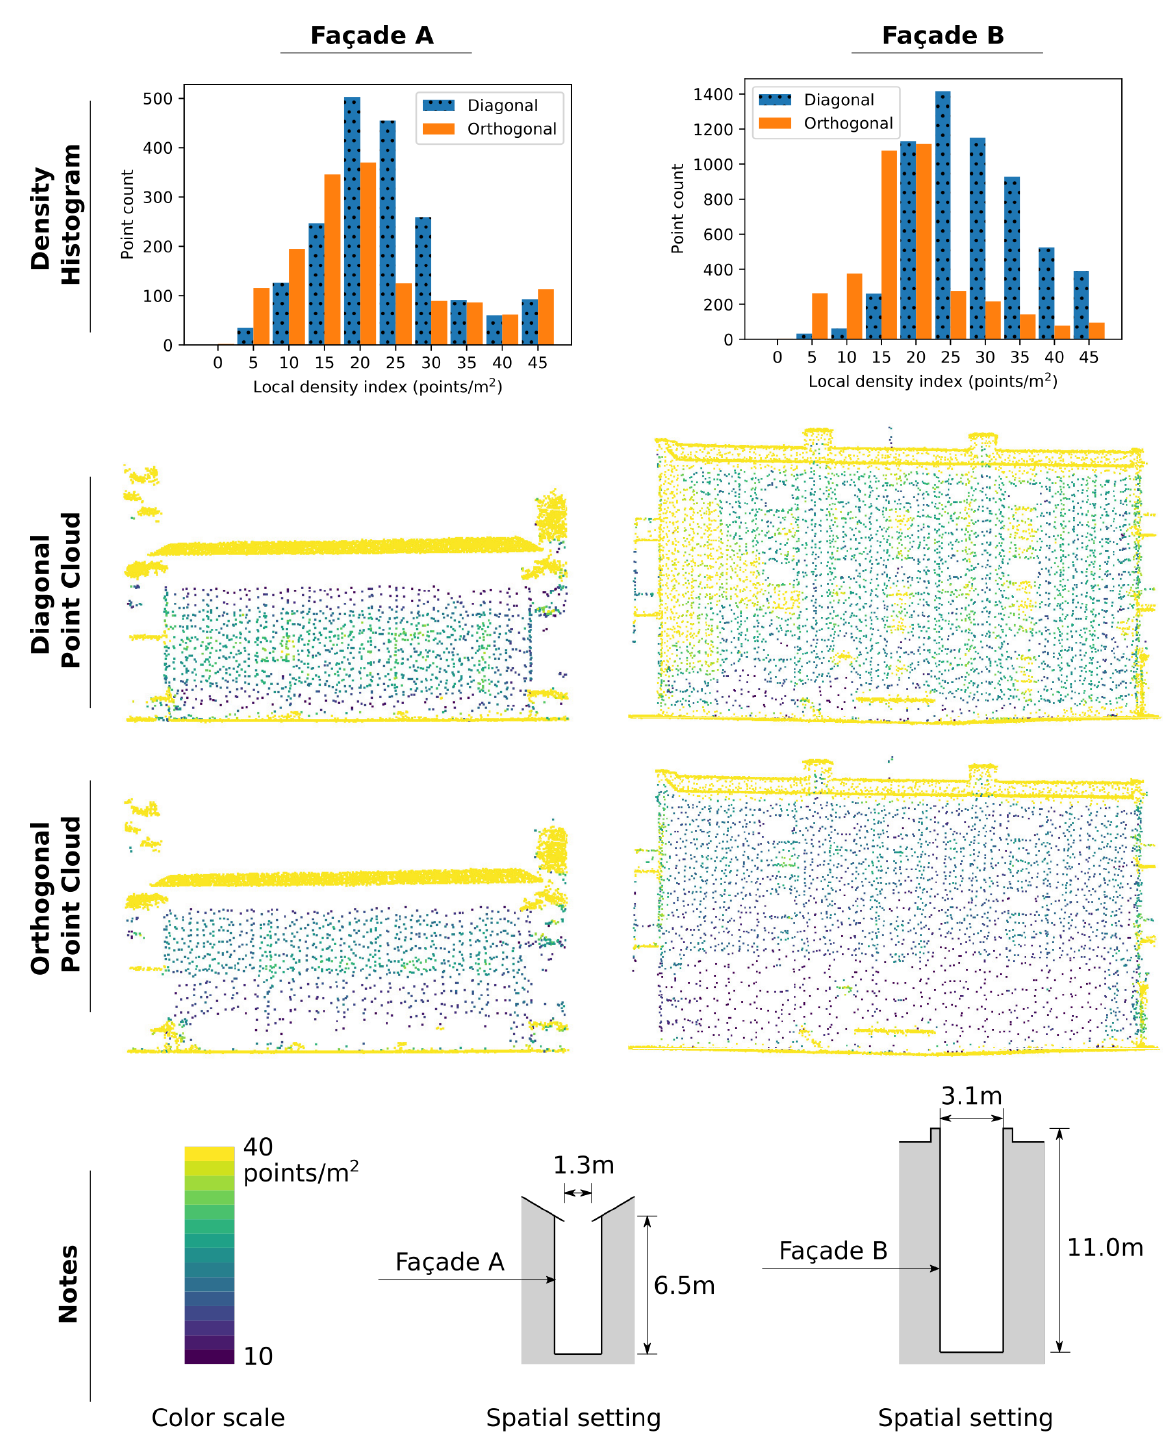
Figure 11. Comparison of acquired vertical data on two façade highly susceptible to street occlusion shows the higher numbers of high-density points in the Diagonal point clouds are observable in both the histogram and the point cloud